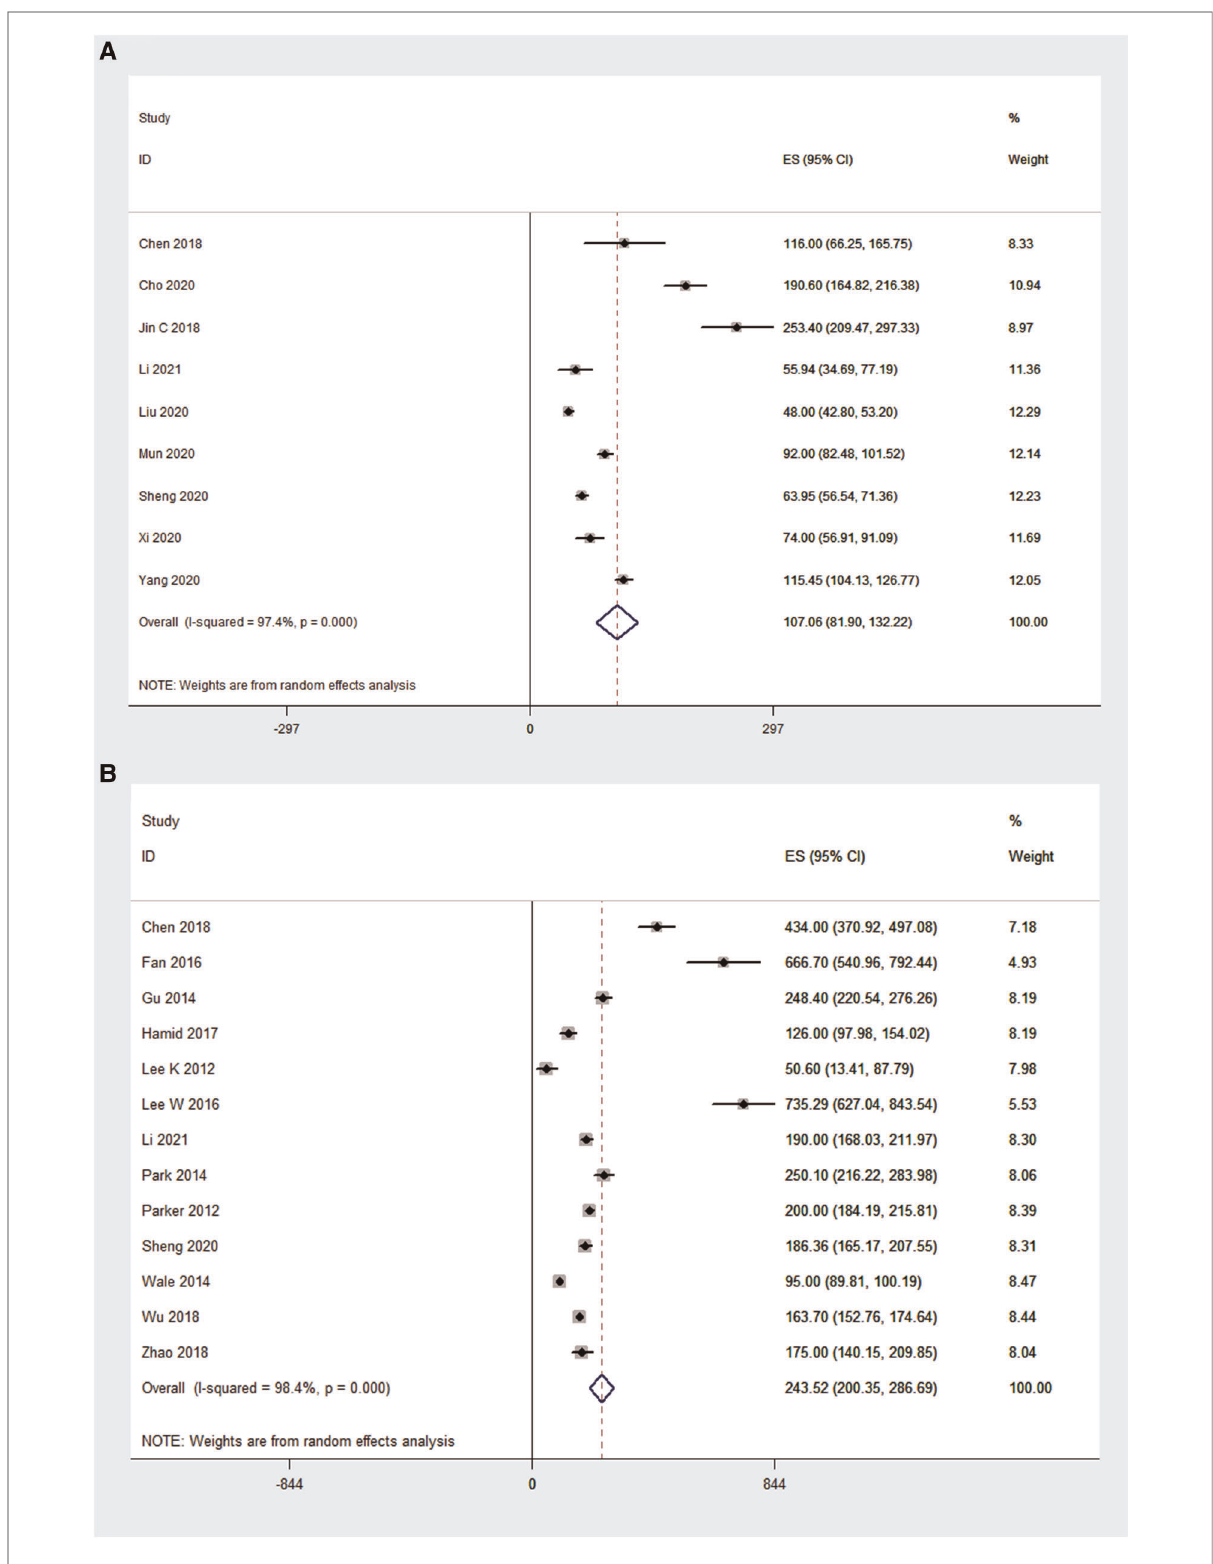
FIGURE 4 Forest plot and pooled estimates of blood loss. Outcomes assessed are ( A ) OLIF group; ( B ) MI-TLIF